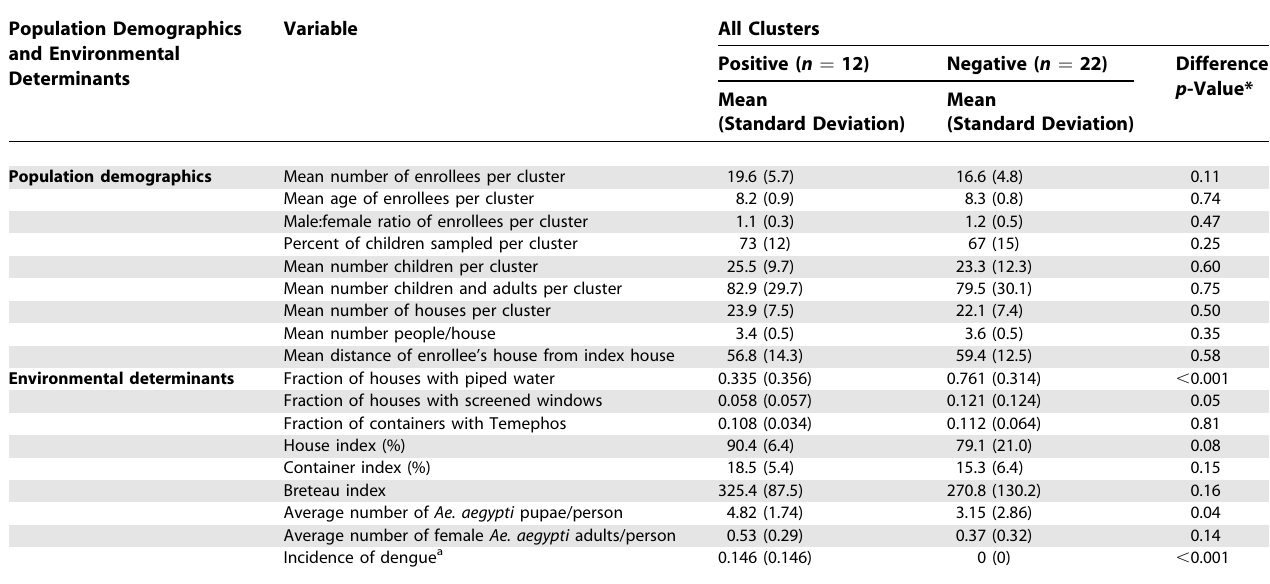
Table 3. Comparison of Dengue-Positive and Dengue-Negative Clusters Population Demographics and